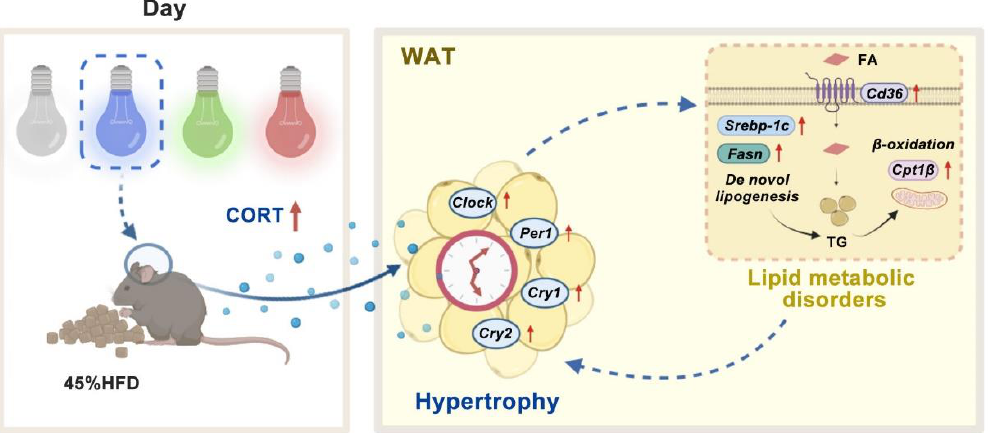
Figure 7. A schematic of our proposed model. Effects of long daytime monochromatic light exposure on adipose hypertrophy in mice fed with HFD. BL exposure increases the level of plasma CORT, which disturbs the circadian clocks in the WAT. Changes in circadian clocks may further regulate the process of lipid metabolism and ultimately lead to adipose hypertrophy. CORT, corticosterone; FA, fatty acid; HFD, high-fat diet; TG, triglyceride; WAT, white adipose tissue. Notably, there are still some limitations within this study. Firstly, the nocturnal rodents used here may not fully mimic the effects of daytime spectral effects in humans, as nocturnal rodents and diurnal humans may have different physiological responses to light